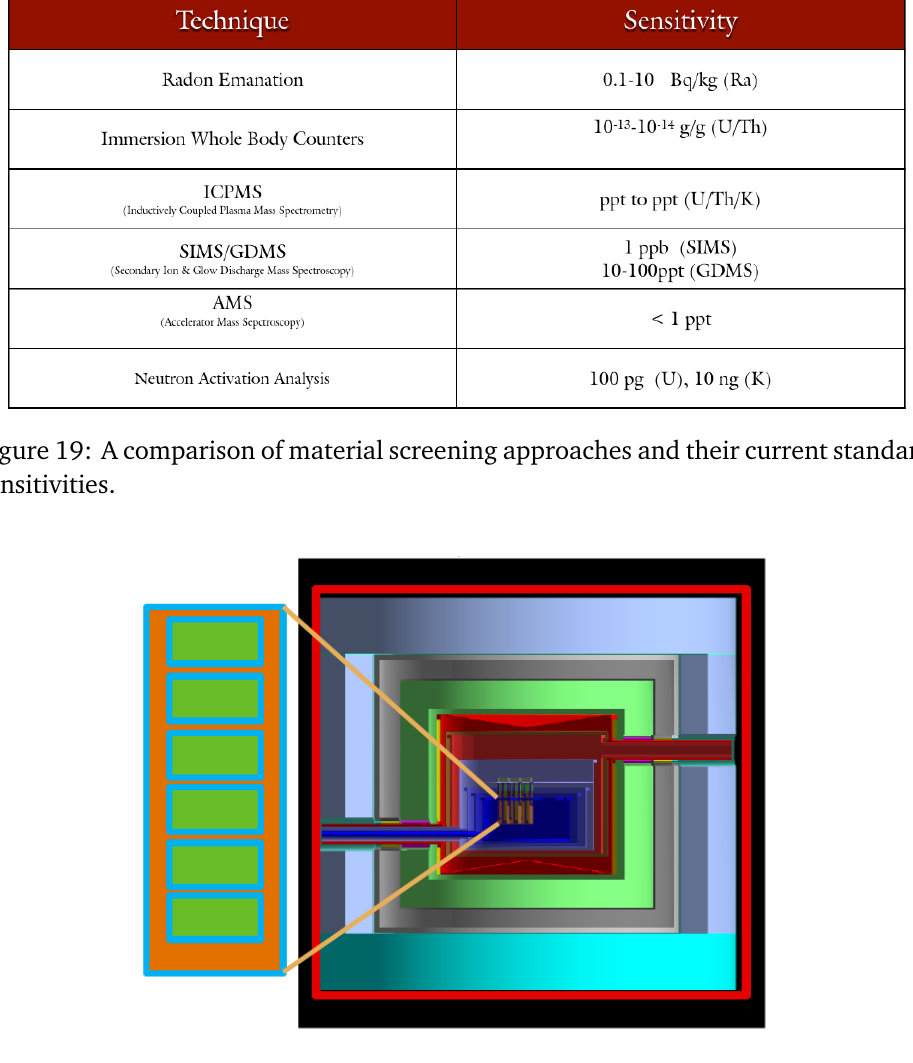
Figure 20: A GEANT4 model of the SuperCDMS dark matter detector. Image pro- vided by the SuperCDMS